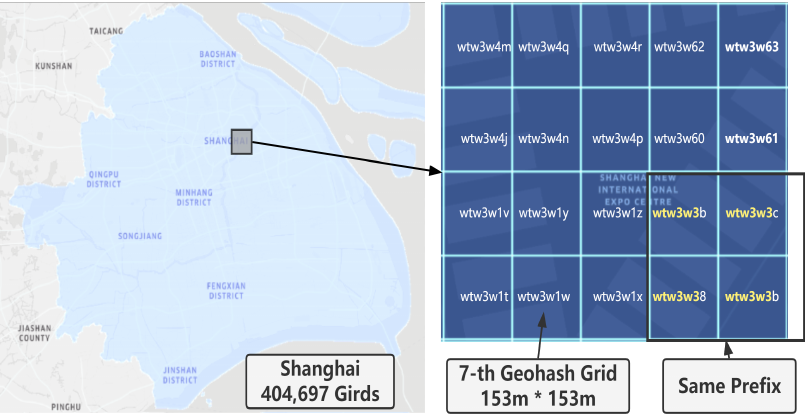
Figure 2. The left part exhibits the area of Shanghai, which covers 404,697 level-7 Geohash grids in total. On the right, is a slice that covers 20 grids. Each level-7 grid can be represented by a unique Geohash string of length 7. All the smaller grids that belong to the same larger grid of the upper level share the same prefix. As shown in the figure, the Geohash of 4 grids in the lower right corner share six characters “wtw3w3” in the prefix since they all belong to a much larger level-6 Geohash grid. The same phenomenon can be observed in all four corners.